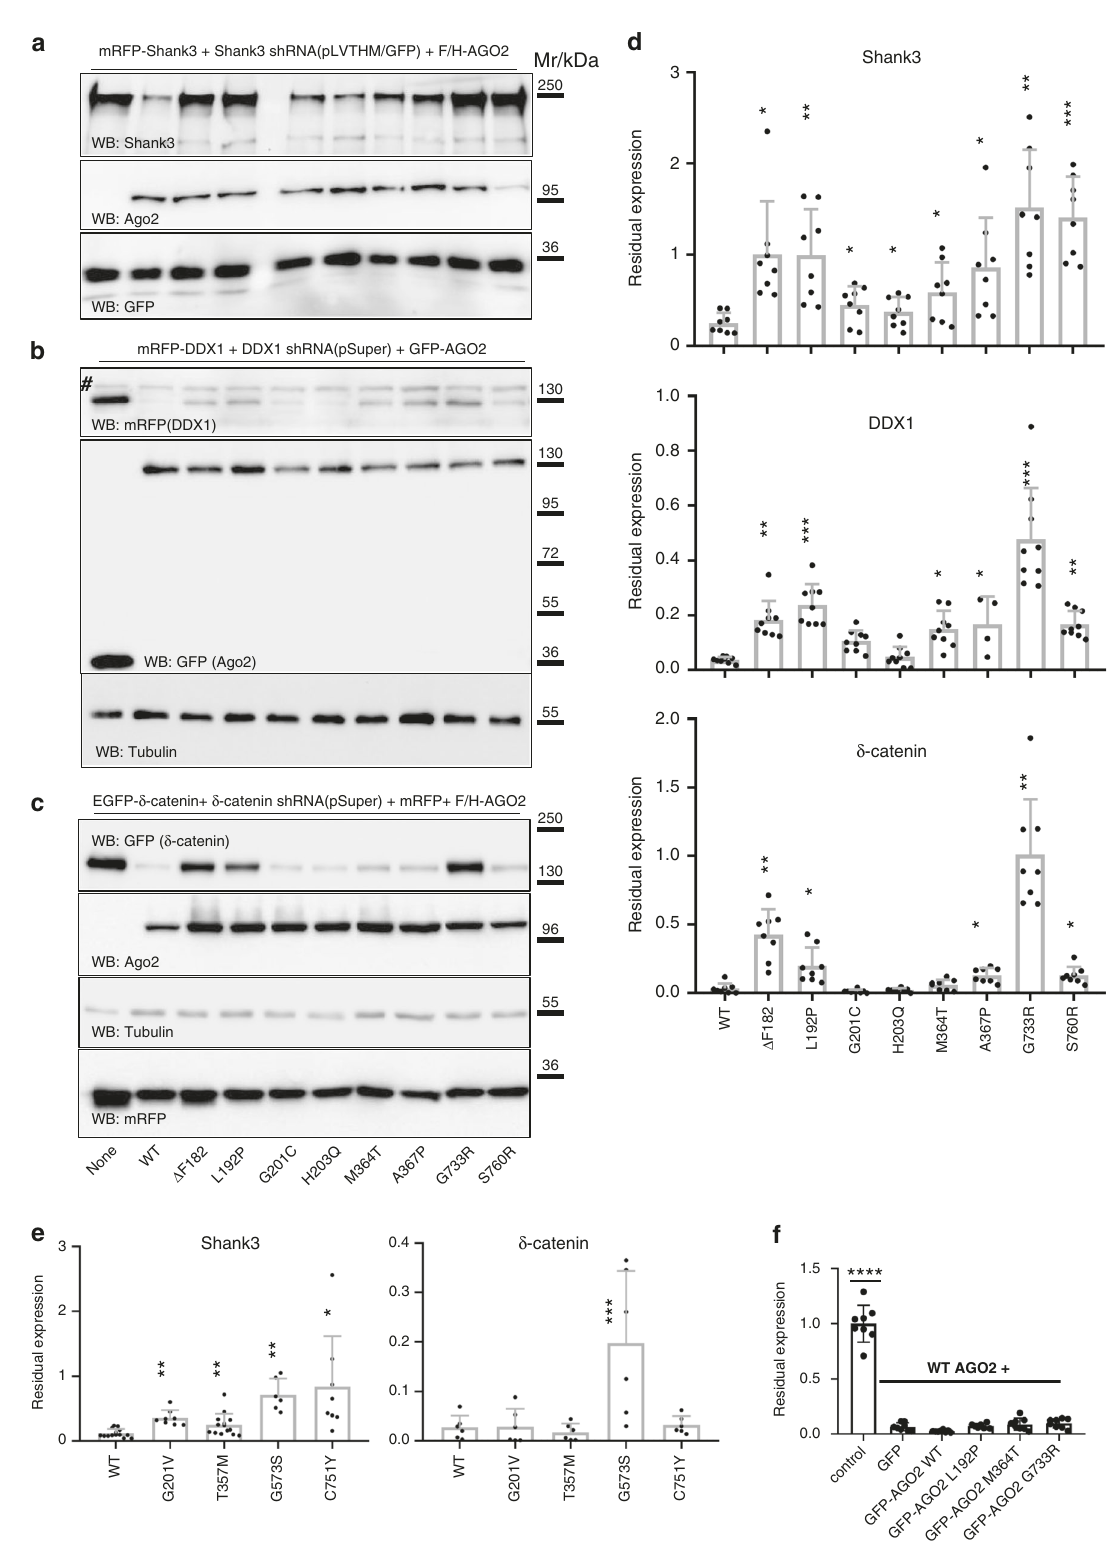
on the function of the WT AGO2 protein. Notably, we observed that knockdown of DDX1 expression by the DDX1 shRNA in the presence of F/H-tagged WT AGO2 was not affected by coex- pression of selected mutant GFP-tagged AGO2 (p.L192P; p. M364T or p.G733R; see Fig. 2f). Thus, these data suggest that, at least the analyzed mutants, result in a